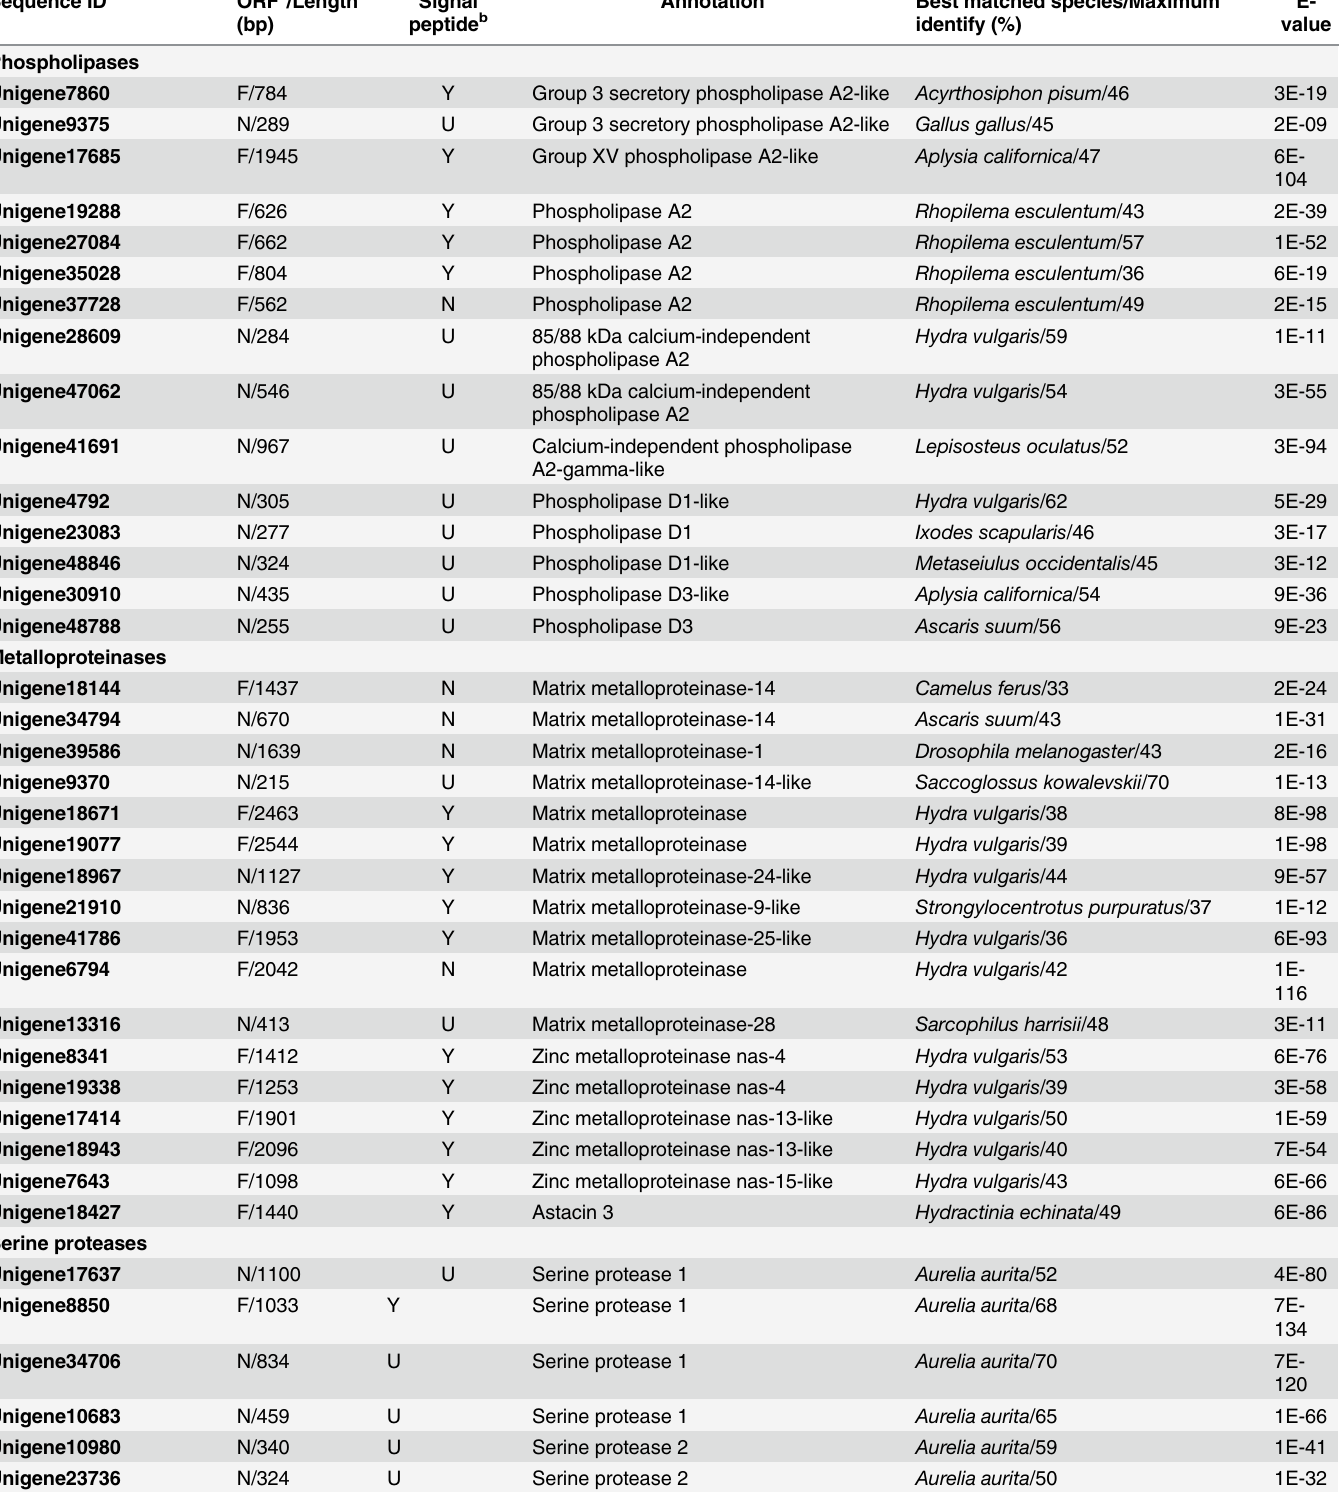
Table 2. Annotation of transcripts similar to known toxin